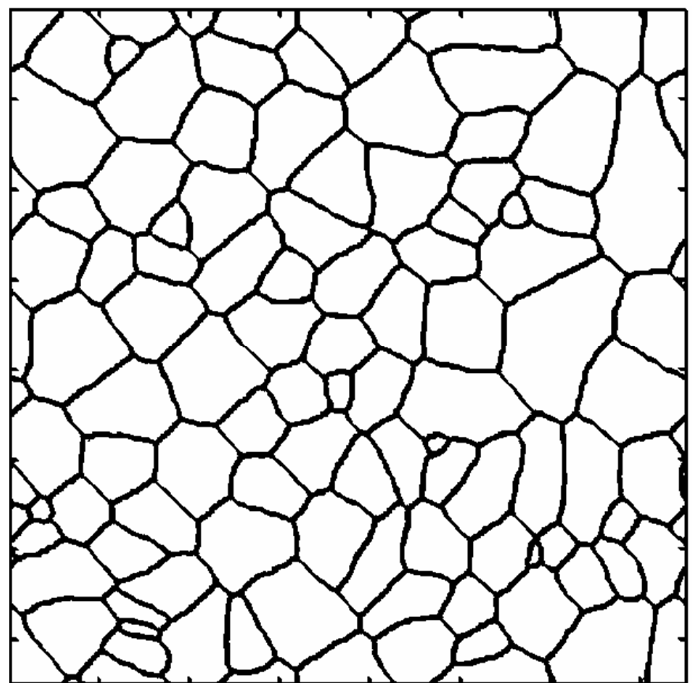
Figure 6. Initial grain model.